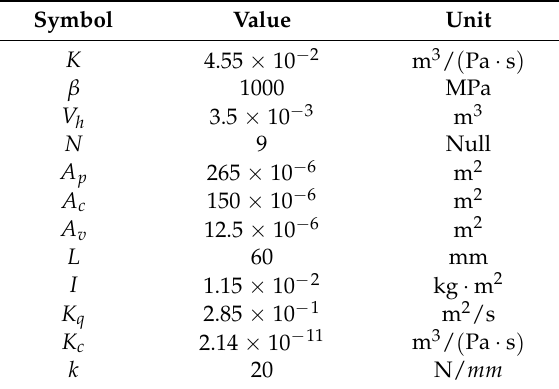
Figure 5. The delivery pressure of EHPAAPP in the case of different input signals with proportional integral derivative (PID) control method. As seen from Figure 6, there is flow disturbance at the fifth second and the pressure command signal is 25 MPa. The pressure value is stable after about 1 s, and the error with the command pressure is 0.2 MPa after flow disturbance. 4.2. LQR Control Method